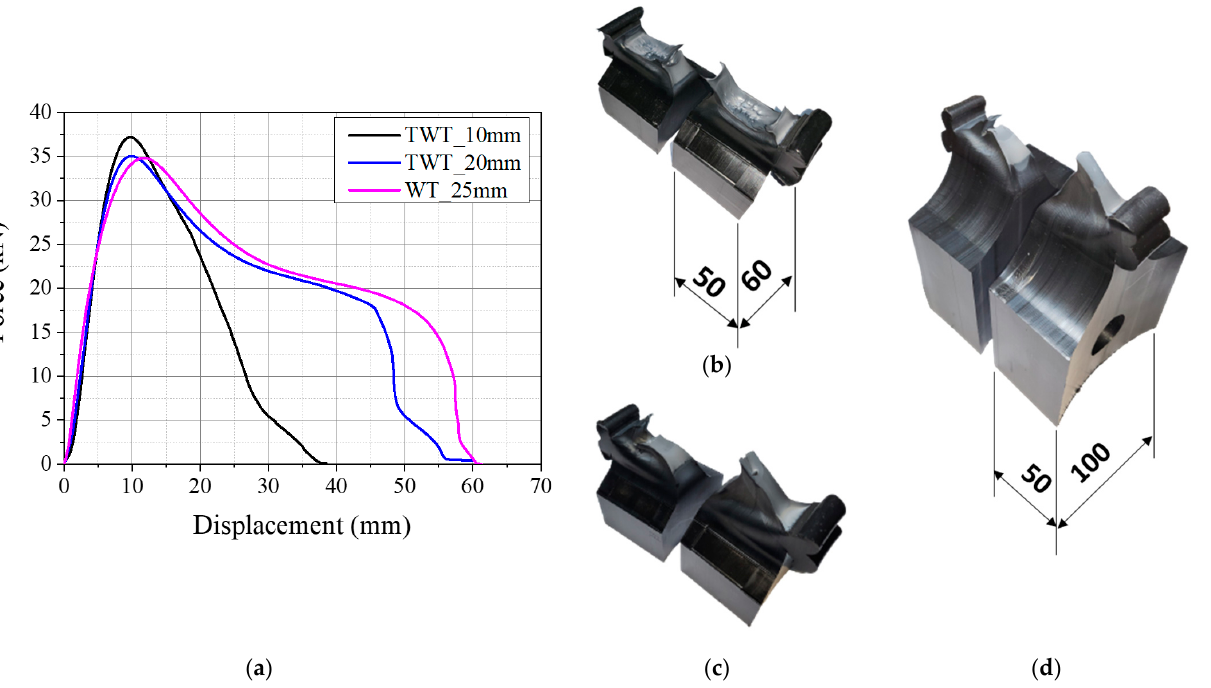
Figure 9. Results of 450 SDR 9 (Type B specimens) pipe BF joint (unit: mm): ( a ) load–displacement curves; ( b ) TWT_10 mm; ( c ) TWT_20 mm; ( d ) WT_25 mm reduced parallel side length.